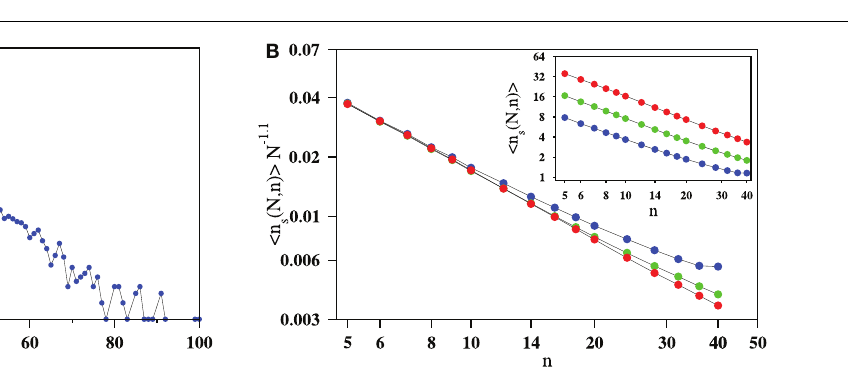
n = 5 with neighbor number n on a log − log scale: N = 128 (blue), 256 (green), and 512 (red). In the main plot the vertical axis has been scaled by N 1 . 1 which leads to a data